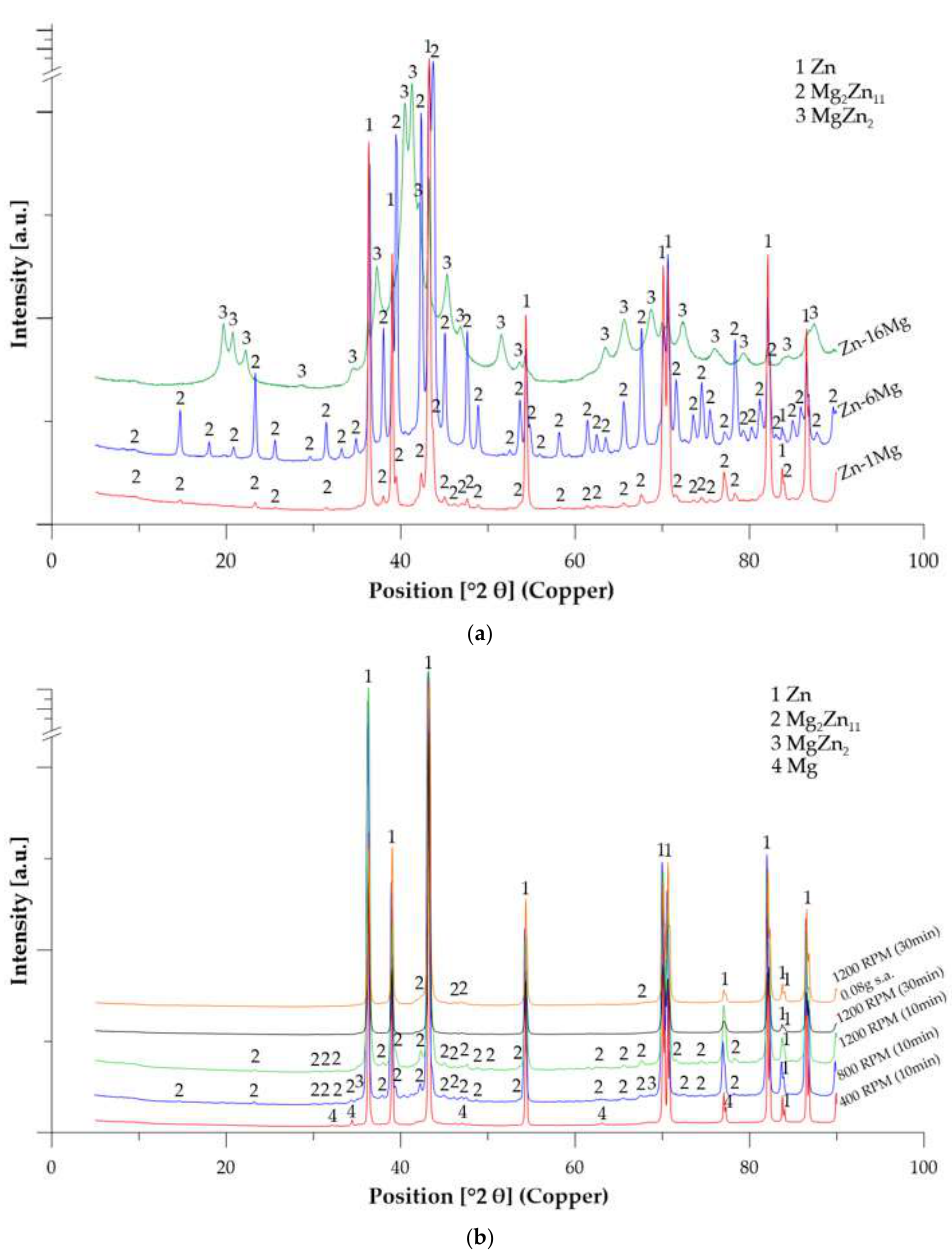
Figure 5. XRD diffractograms of mechanically alloyed materials: ( a ) Zn-xMg (x = 1, 6, 16 wt.%) pow- ders milled at 1200 RPM for 1 h, ( b ) Zn-1Mg powders milled under different conditions. powders milled at 1200 RPM for 1 h, ( b ) Zn-1Mg powders milled under different